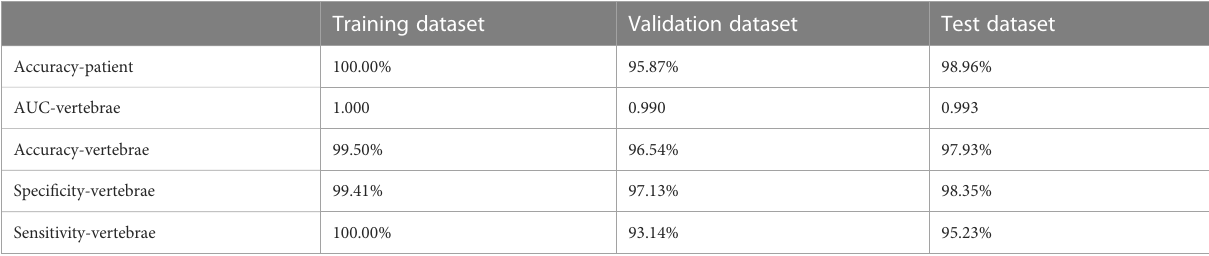
TABLE 2 Evaluation of fracture detection on a patient level and vertebrae